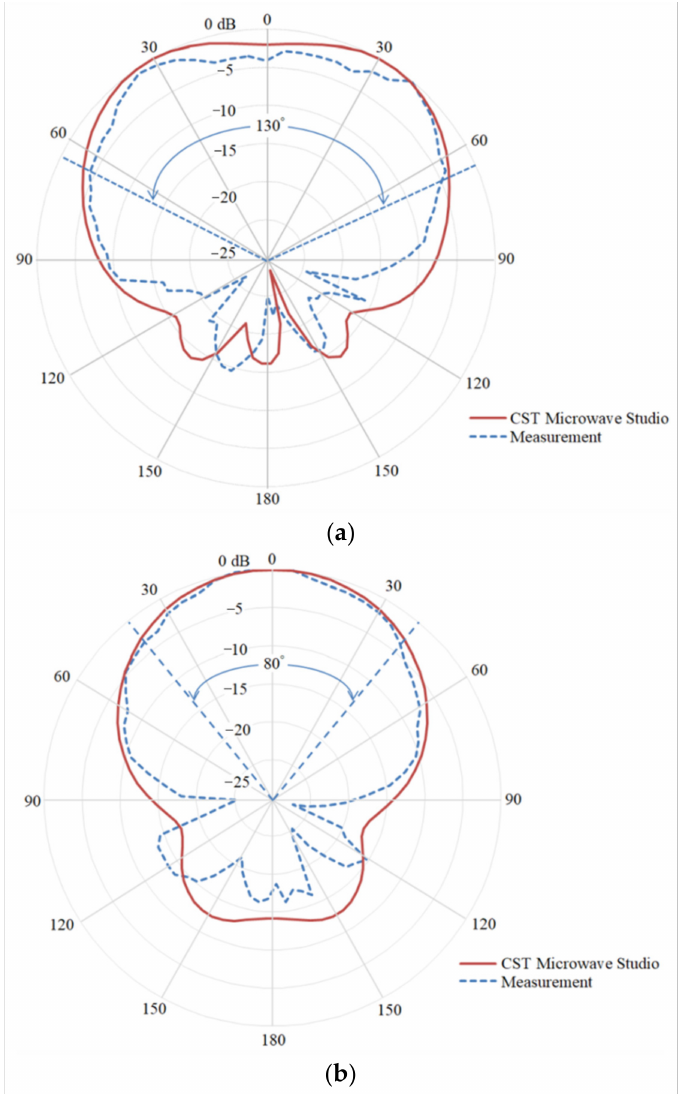
Figure 16. Comparison between the measured and the simulated normalized radiation pattern at 5.0 GHz: ( a ) E-plane (y-z plane); ( b ) H-plane (x-z